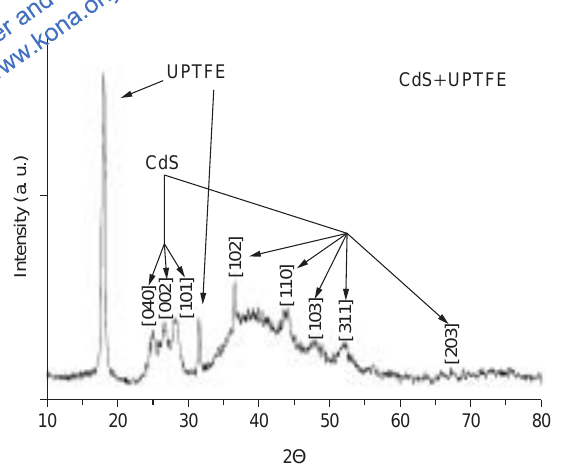
Fig. 11 Diffraction pattern of the sample containing CdS nano- particles on the surface of the PTFE